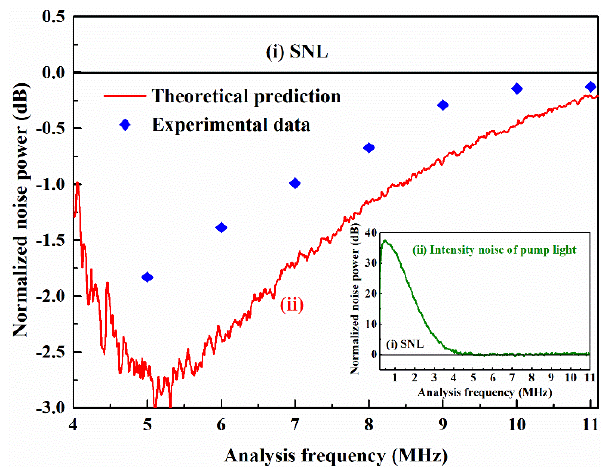
Figure 4. Normalized noise power spectrum of the intensity difference between two down-conversion beams. Curves (i): normalized SNL, curve (ii): theoretical prediction, blue diamonds: experimental data. The inserted figure is the normalized intensity noise power spectrum of the pump.